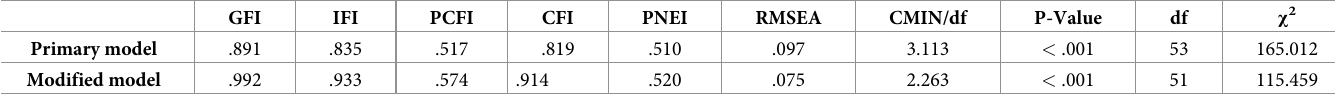
The study aimed to analyze the relationships among PA level, BMI, and gender in the QOL of Students. Table 3. Fit indices of the primary and modified